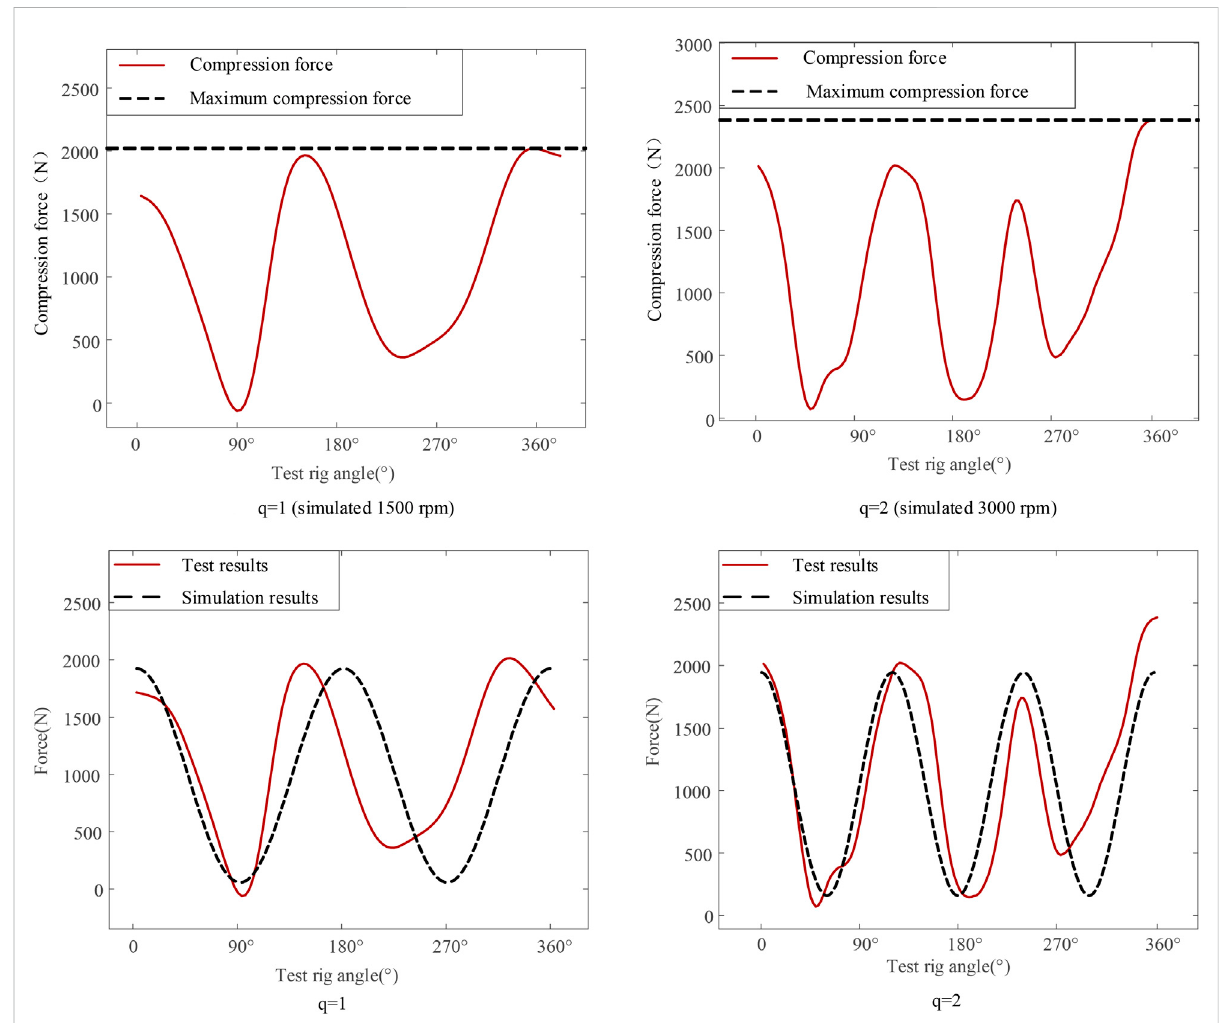
FIGURE 15 Test results on the magnitude and variation pattern of the compression force of the q = 1 test